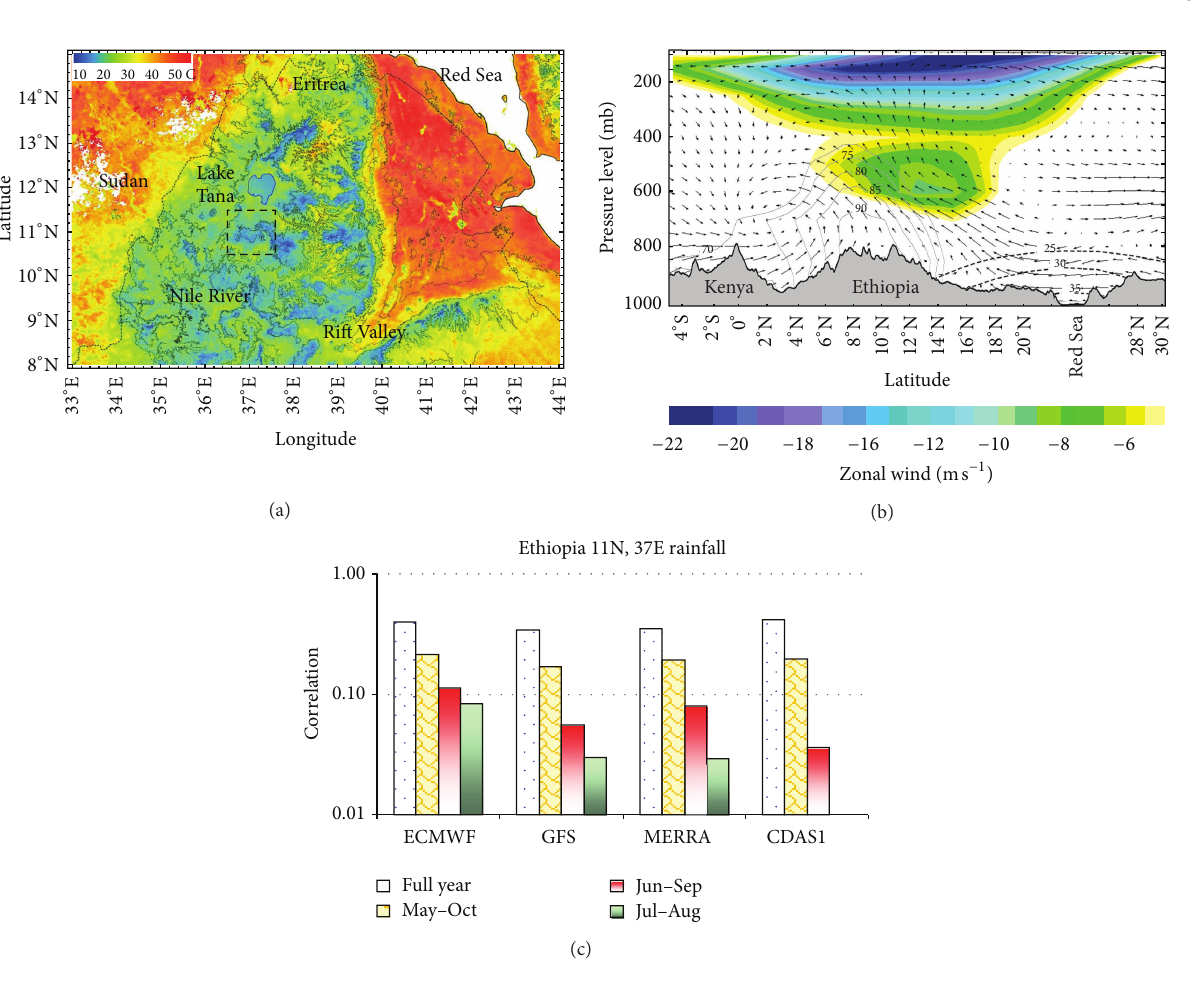
Figure 1: (a) MODIS land surface temperature 15 July–15 August, 2011, and elevation contours at 800 m intervals. (b) July–August, 2011, N-S section on 37 ∘ E of the circulation (meridional vertical VW vectors, max = 5m/s), zonal wind (shaded), relative humidity > 70% (contours), and temperature > 25 ∘ C (dashed) from NCEP2, with topographic profile. (c) Intercomparison of cross-correlations between model estimated daily rainfall and ARC2 observations 2000–2012, for a 1 ∘ grid-cell (dashed in a), in diminishing